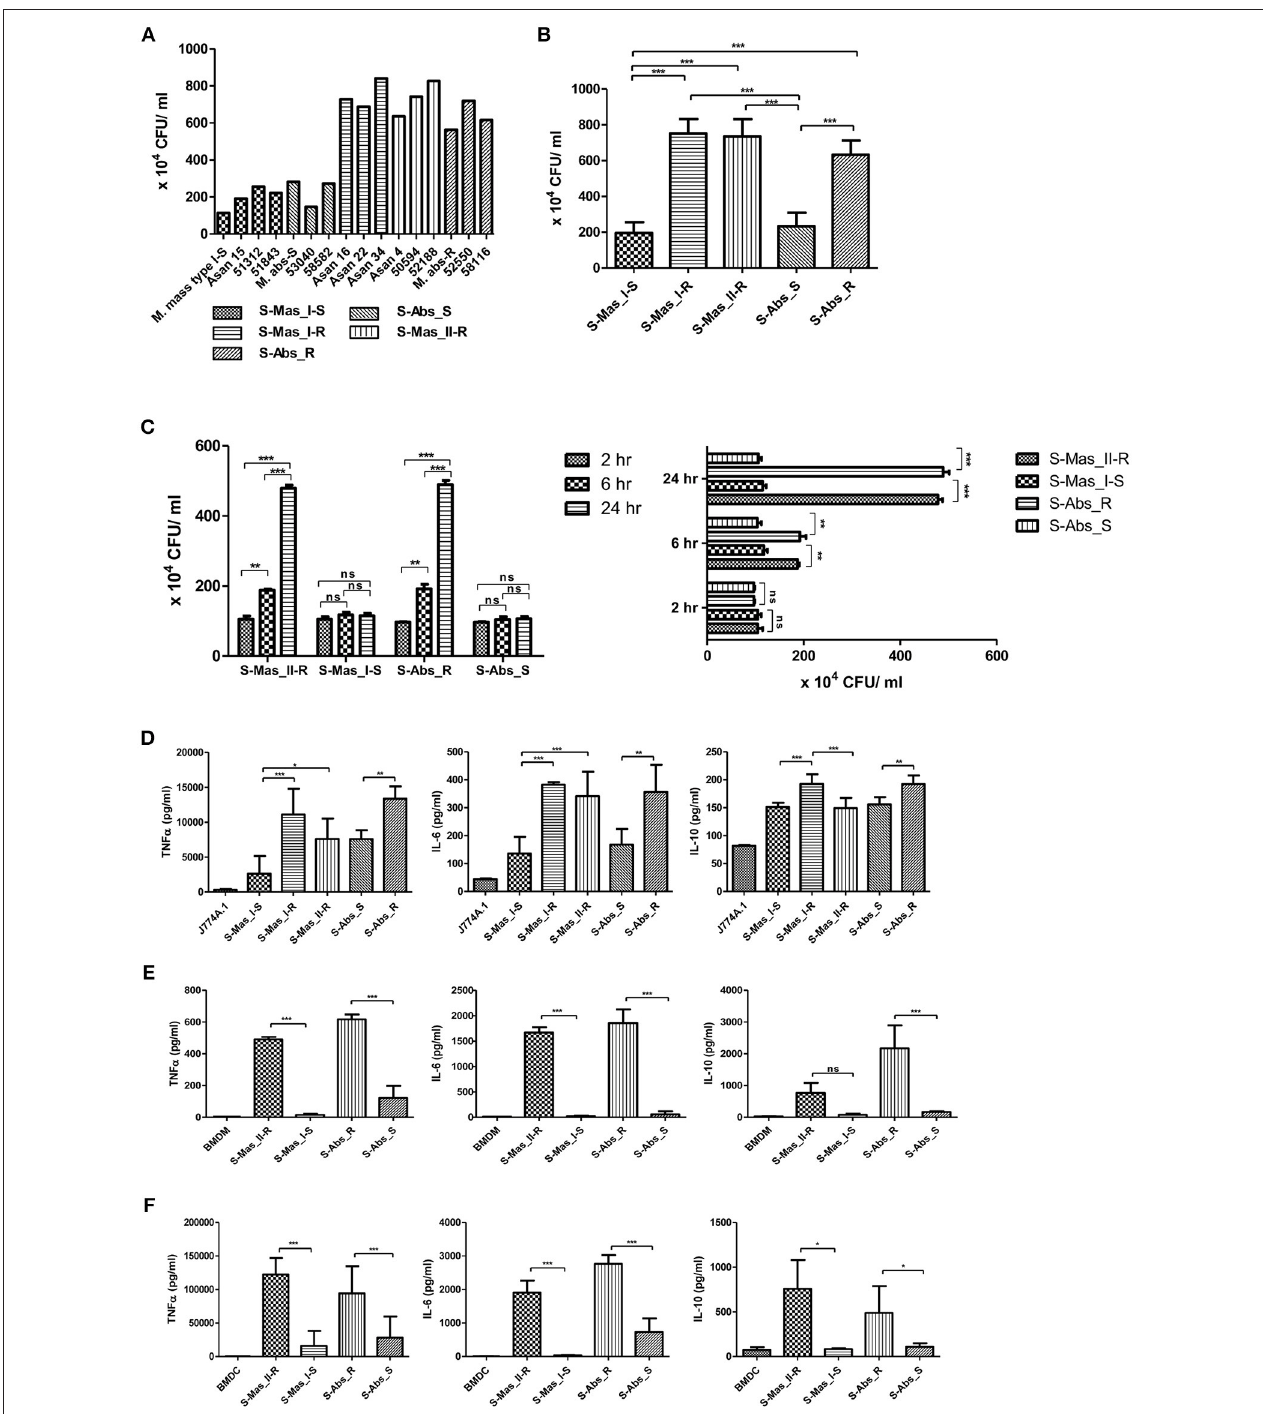
FIGURE 1 | Comparison of intracellular survival and proinflammatory cytokine production of MAB-R and -S strains of various subspecies or genotypes in infected murine macrophage. (A) CFU assays of MAB-R and -S strains of various subspecies or genotype [S-Abs smooth strains (S-Abs_S): M. abscessus type strain ATCC 19977 smooth strain, Asan 53040, and Asan 58582; S-Abs rough strains (S-Abs_R): M. abscessus type strain ATCC 19977 rough strain, Asan 52550 and Asan 58116; S-Mas type I-Smooth (S-Mas_I-S): type strain, Asan 15, Asan 51312, and Asan 51843; S-Mas type I-Rough (S-Mas_I-R): Asan 16, Asan 22, and Asan 34; and S-Mas type II-Rough (S-Mas_II-R): Asan 4, Asan 50594, and Asan 62188] (1 × 10 7 bacteria; 10M.O.I.) in infected J774A.1 (1 × 10 6 ) cells at 37 ◦ C for 24h.p.i. (B) The mean number of CFUs of various subspecies or genotypes of MAB surviving in infected J774A.1 cells. (C) Comparison of the number of CFUs from MAB-R